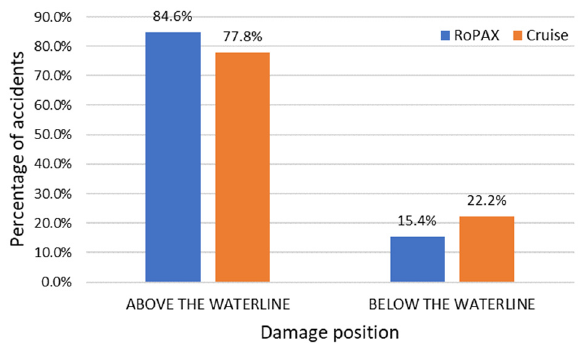
Figure 17 . Vertical distribution of damage breaches . Figure 17. Vertical distribution of damage breaches.